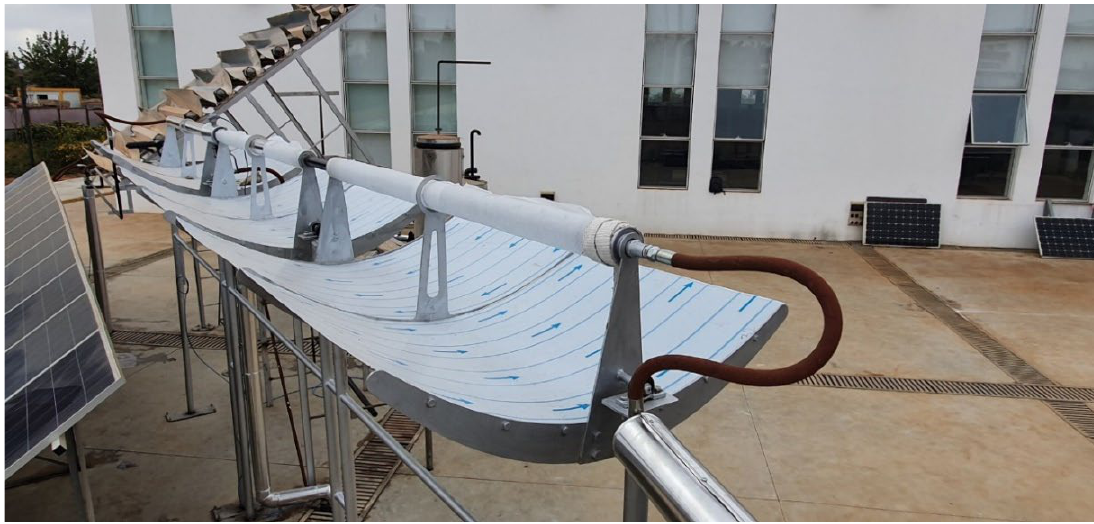
Figure 4. Parabolic trough collector.